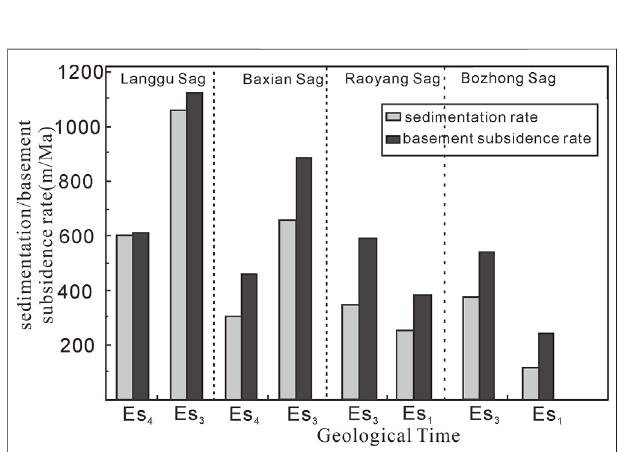
FIGURE13 | Comparison ofbasement subsidence/sedimentation rates in different rifting periods between Langgu Sag and other key depressions of Bohai Bay